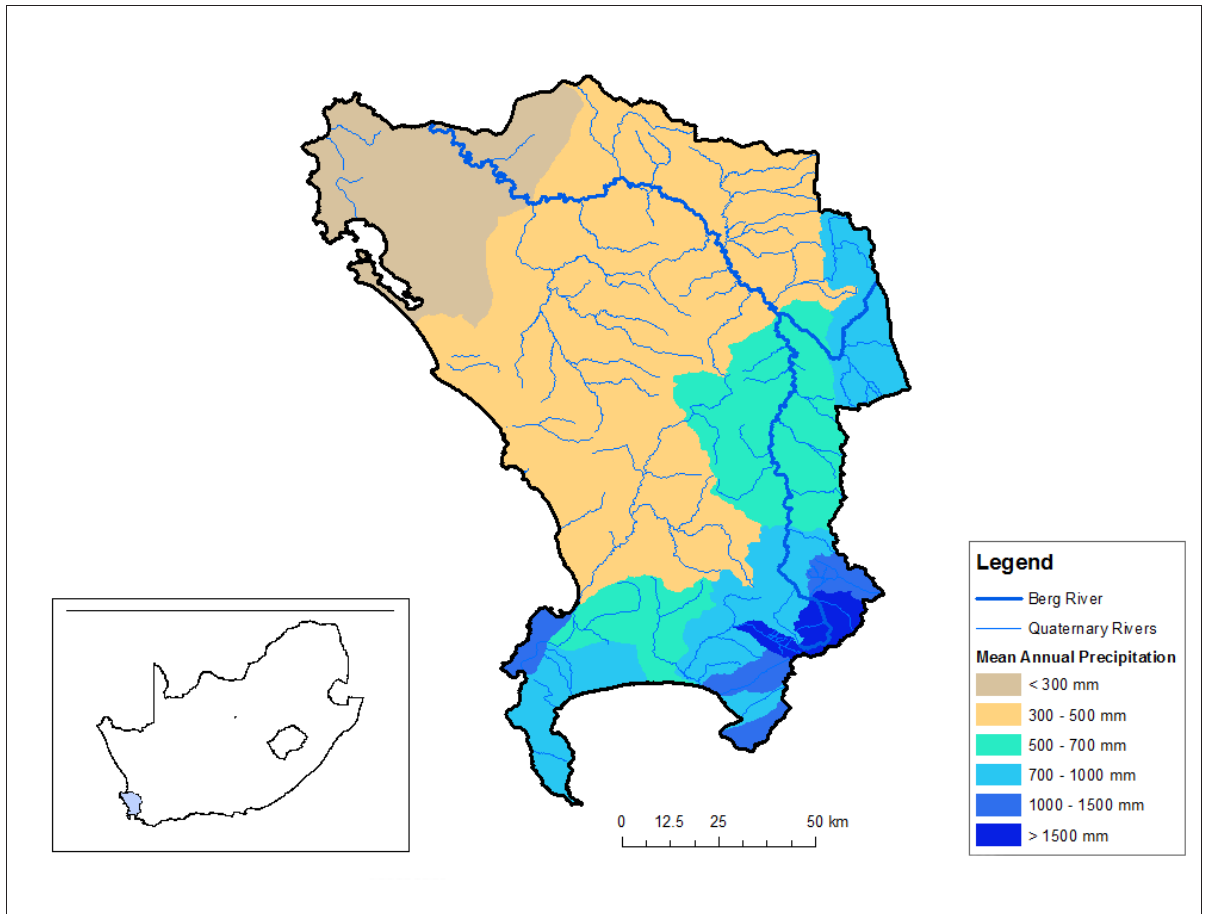
Figure 1: Mean annual precipitation and quaternary rivers in the Berg Water Management